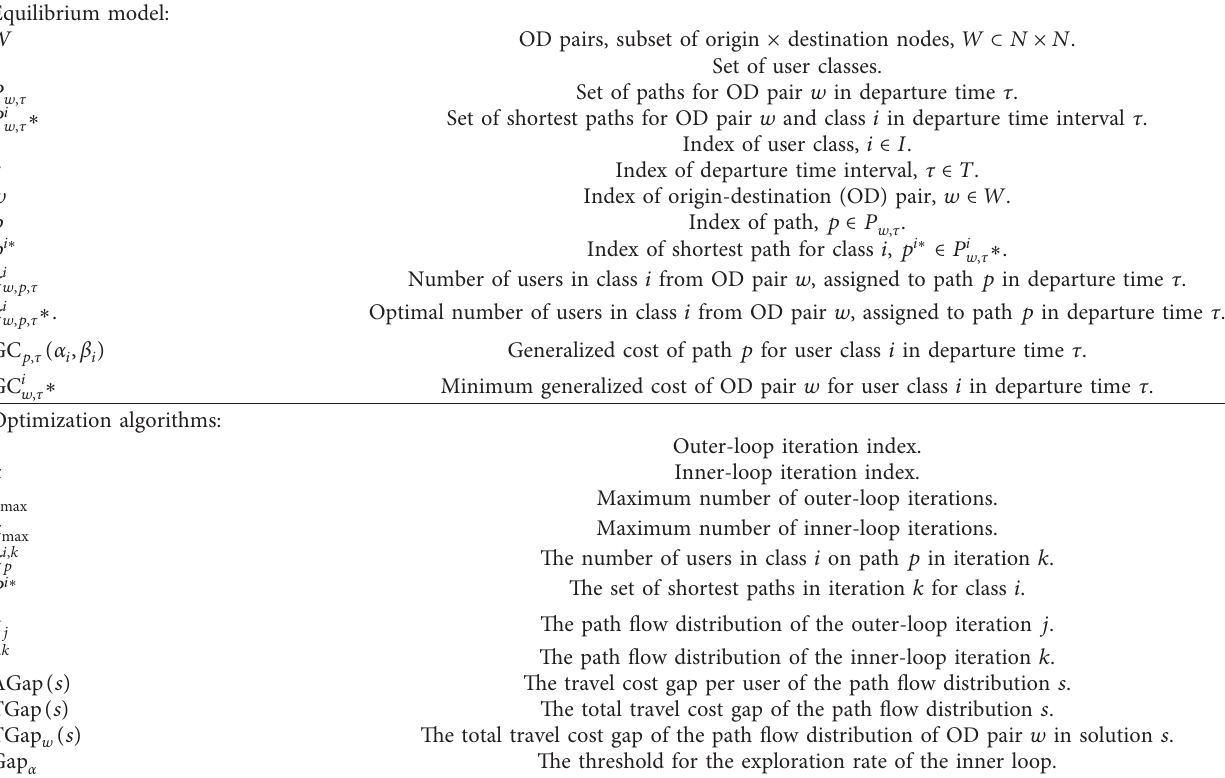
Table 1: List of notations used in this article.